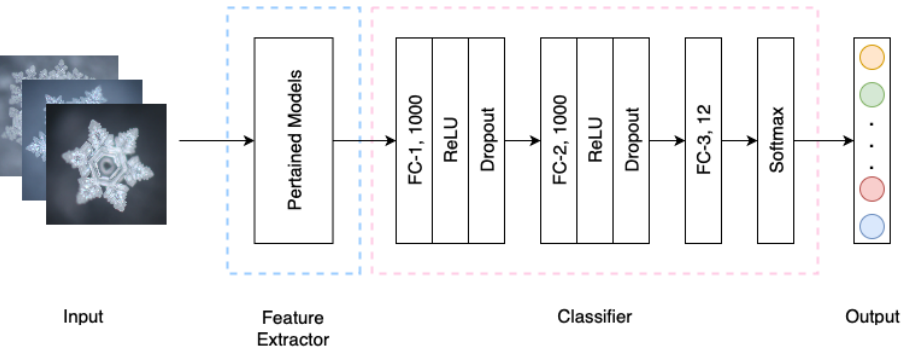
Figure 3. Classification architecture overview. The feature extractor can be replaced by RAE pre- trained model or ImageNet pre-trained model. The features are used as input for the next step. The classifier contains 3 fully connected layers, each of them is followed by ReLU and a dropout layer. The last FC outputs the predicted probability distribution. Softmax is added to get the final